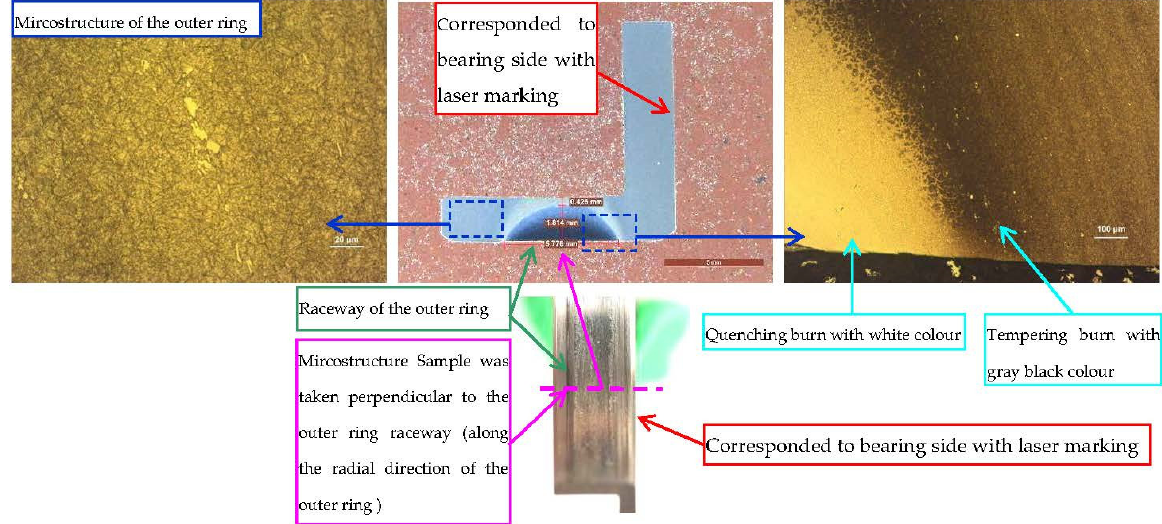
Figure 16. Typical microstructure and burns of the outer ring. There are serious microstructure burns induced by heavy wear between rollers and ring raceways in the rollers. The burned area corresponding to the bearing side with laser marking was heavier than that of the other side. The microstructure of the rollers was a homogeneous structure and consisted of acicular martensite + carbide. The typical microstructure and burns of the rollers are shown in Figure 17.